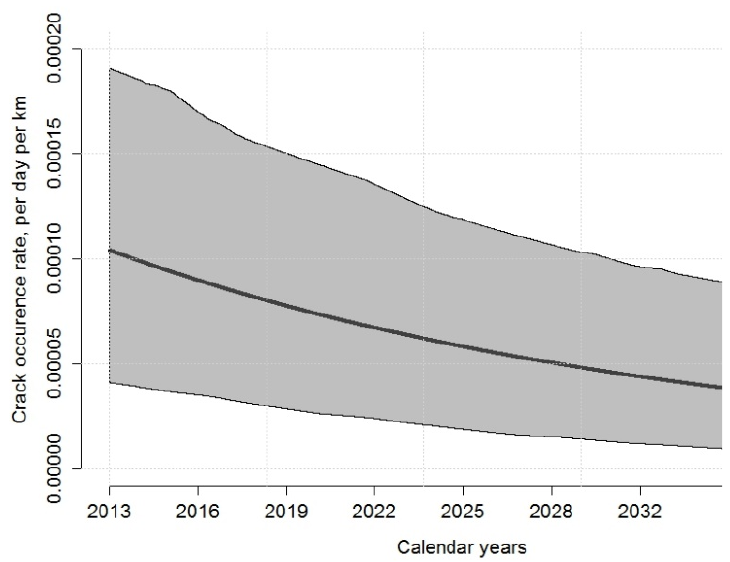
Figure 4. Cracking rate dynamics as obtained by Bayesian inference and CDP model.